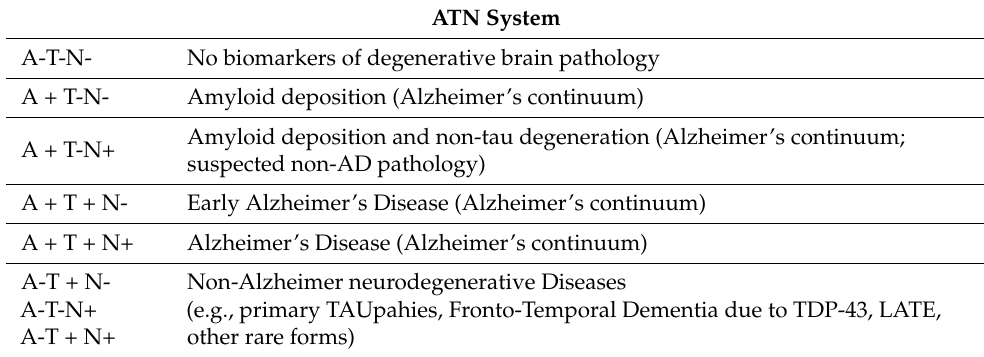
Table 1. Individual score obtained from the combination of ATN